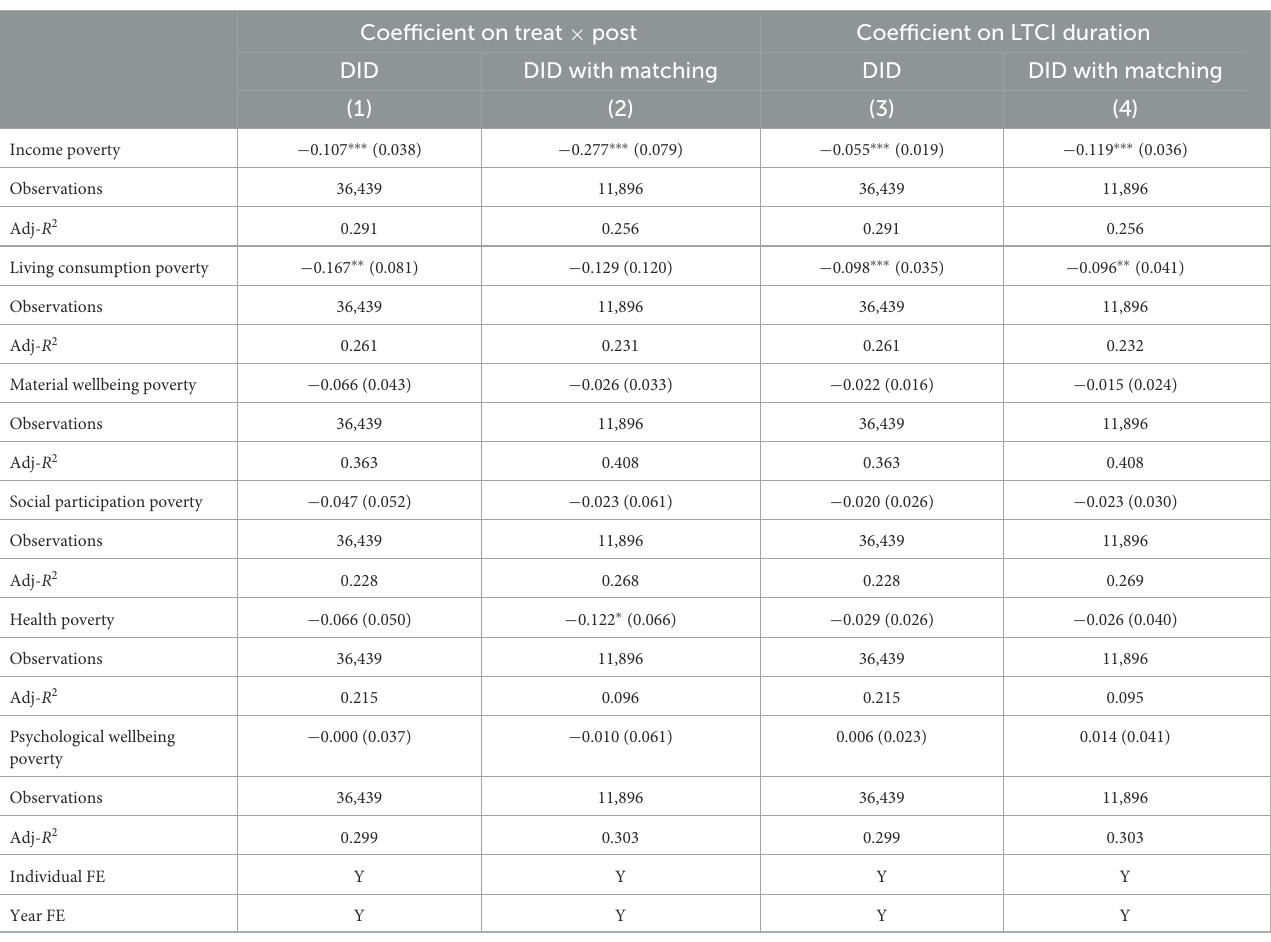
TABLE 4 Effect of LTCI on poverty in each dimension.